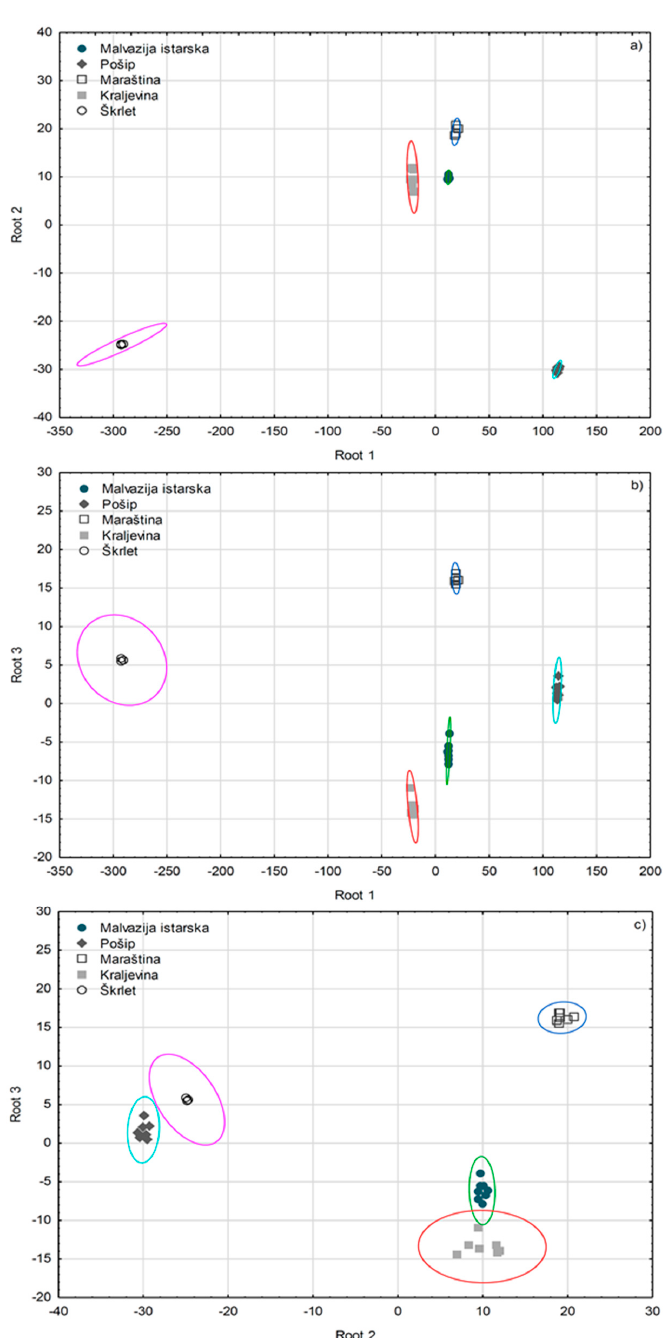
Figure 3. Separation of Croatian monovarietal wines according to variety defined by the first three discriminant functions (roots) obtained by forward stepwise discriminant analysis (SLDA) on the basis of volatile aroma compound composition determined by GC-MS and GC × GC-TOF-MS analysis. ( a ) root 1 vs root 2; ( b ) root 1 vs root 3; ( c ) root 2 vs root 3.